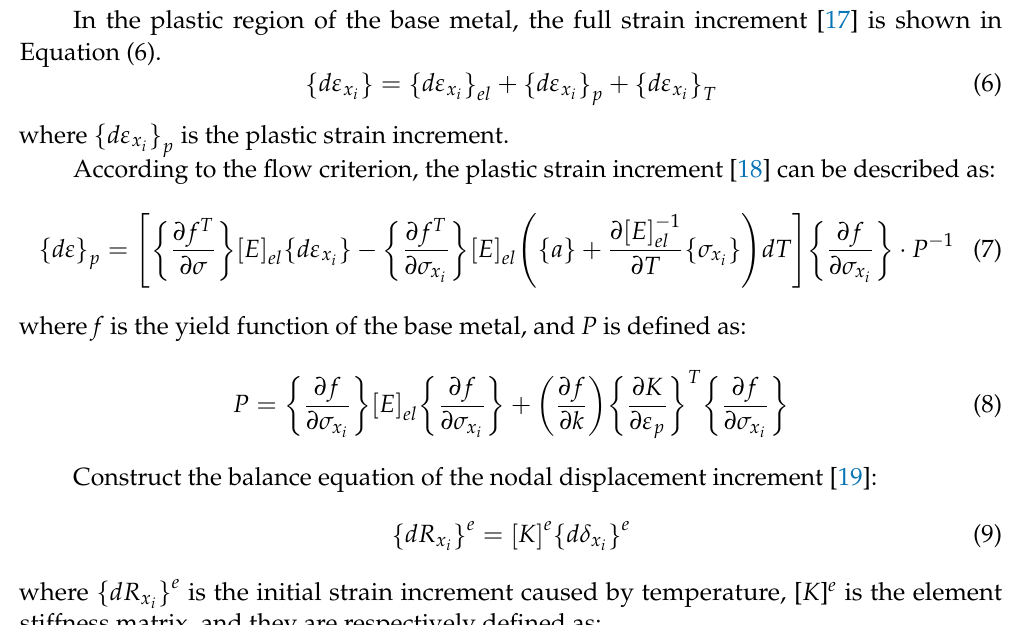
Figure 1. The stress distribution of the heated surface of the base metal unit.